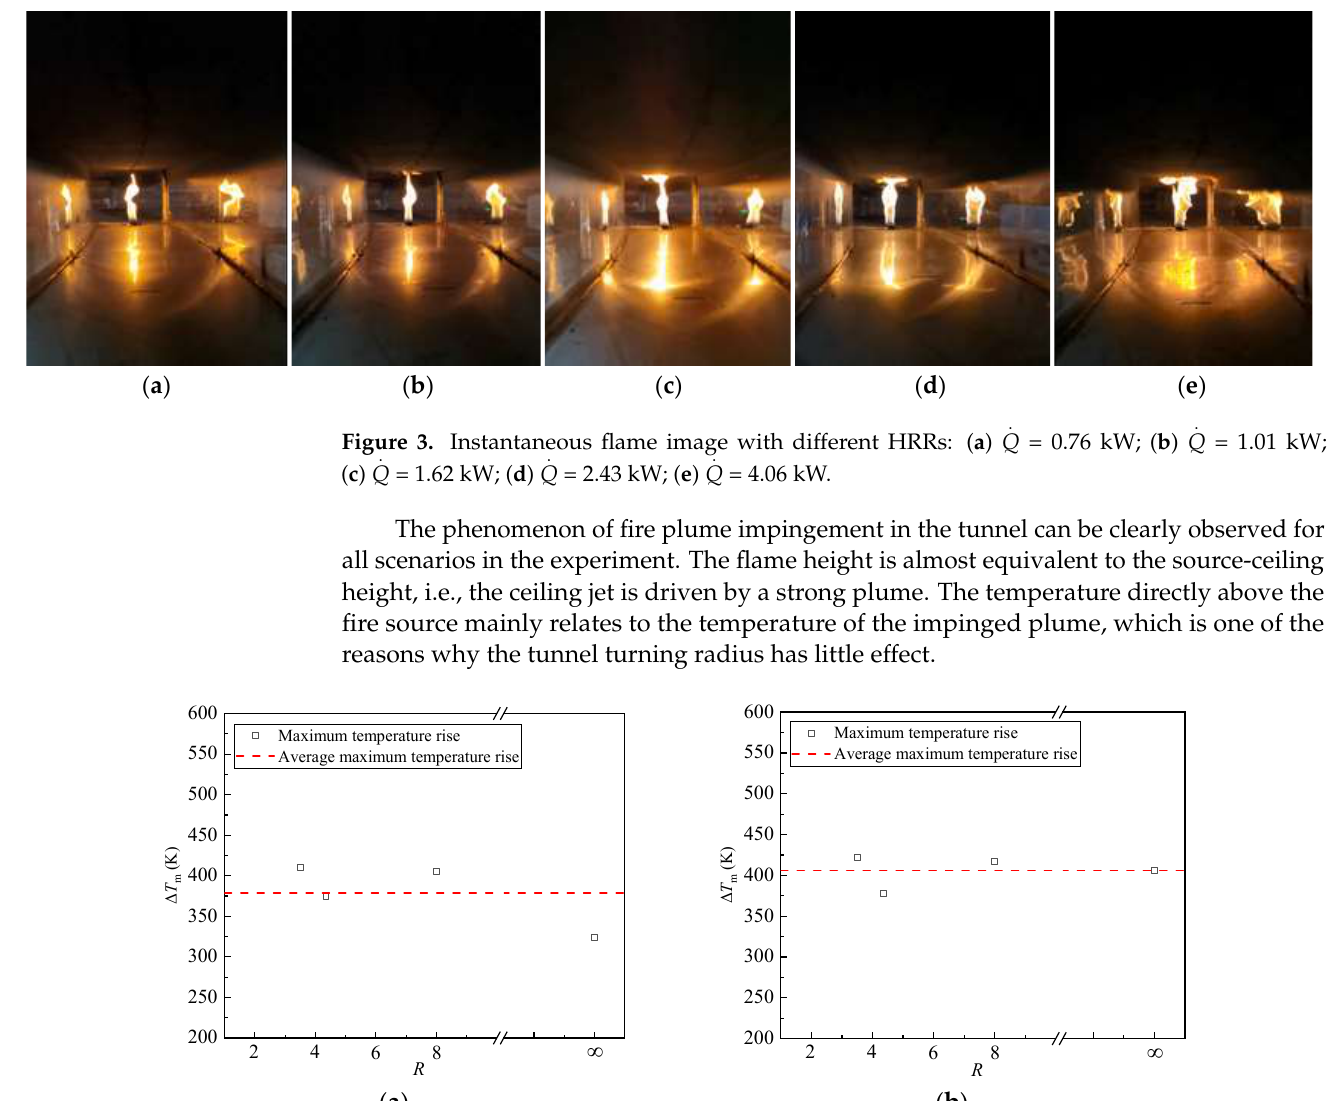
  = 0.76 kW; ( b ) Q = 1.01 kW; ( c )